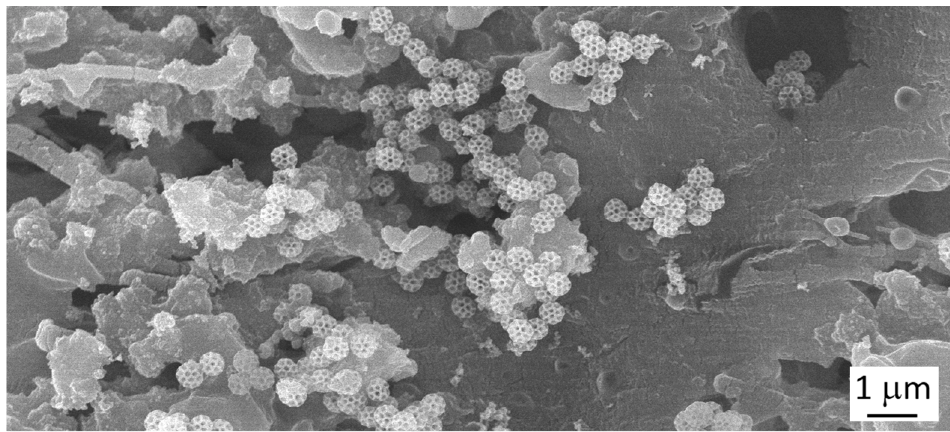
Figure 7. An example of the location of brochosome agglomerates in the aerosol sample.